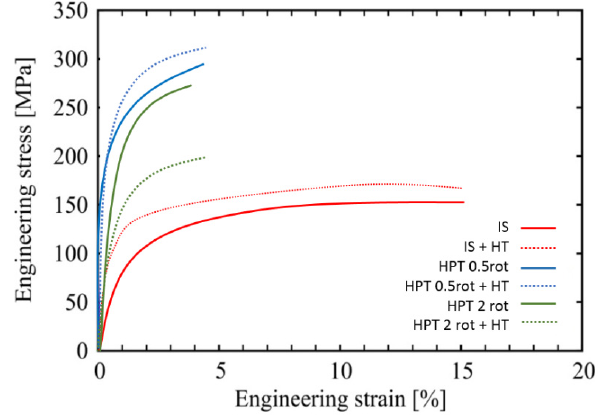
not showing any response to thermal treatment after HPT-processing. The average values of strength and ductility measured in the tensile tests are summarized in Table 4.